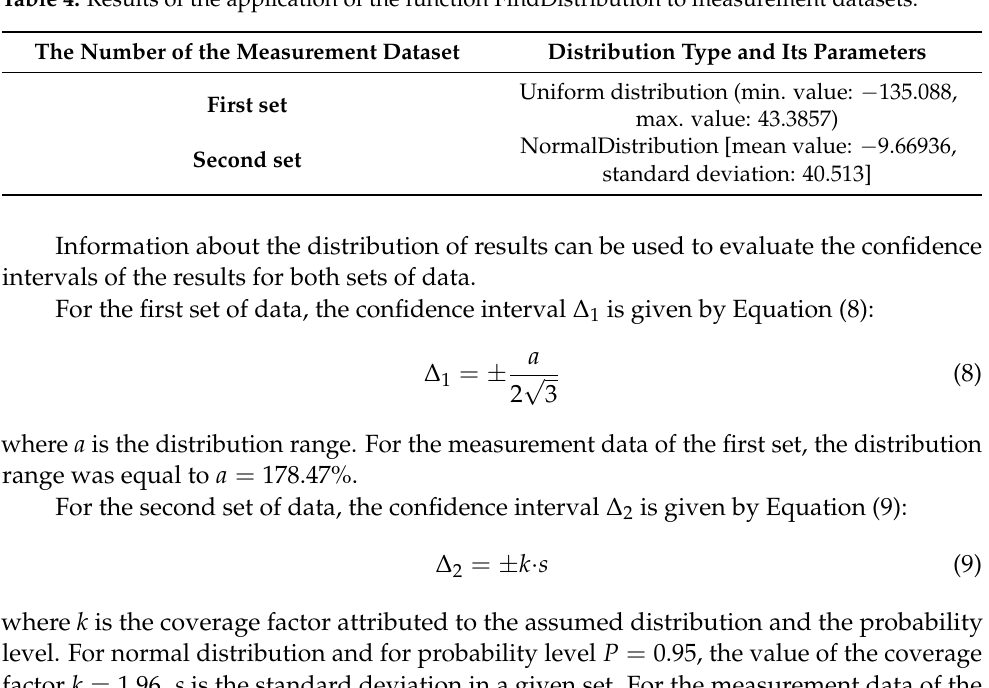
Table 4. Results of the application of the function FindDistribution to measurement datasets.